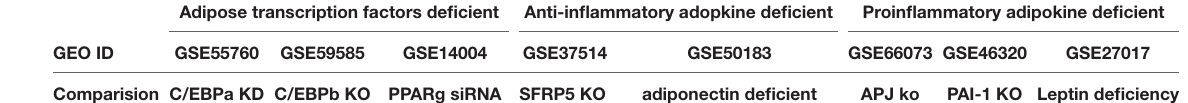
TABLE 4B | Proadipogenic transcription factors C/EBPa and PPARg promote the expression of M1 macrophage markers, C/EBPa and C/EBPb inhibit the expressions of M2 macrophage markers, and higher expressions of Mhb, Mhem, and HA-mac subtype markers in adipose tissues may result from stimulation in adipose tissue environments rather than that in